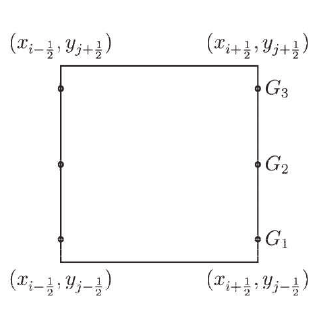
Figure 1. A sketch of WENO reconstruction on a rectangular